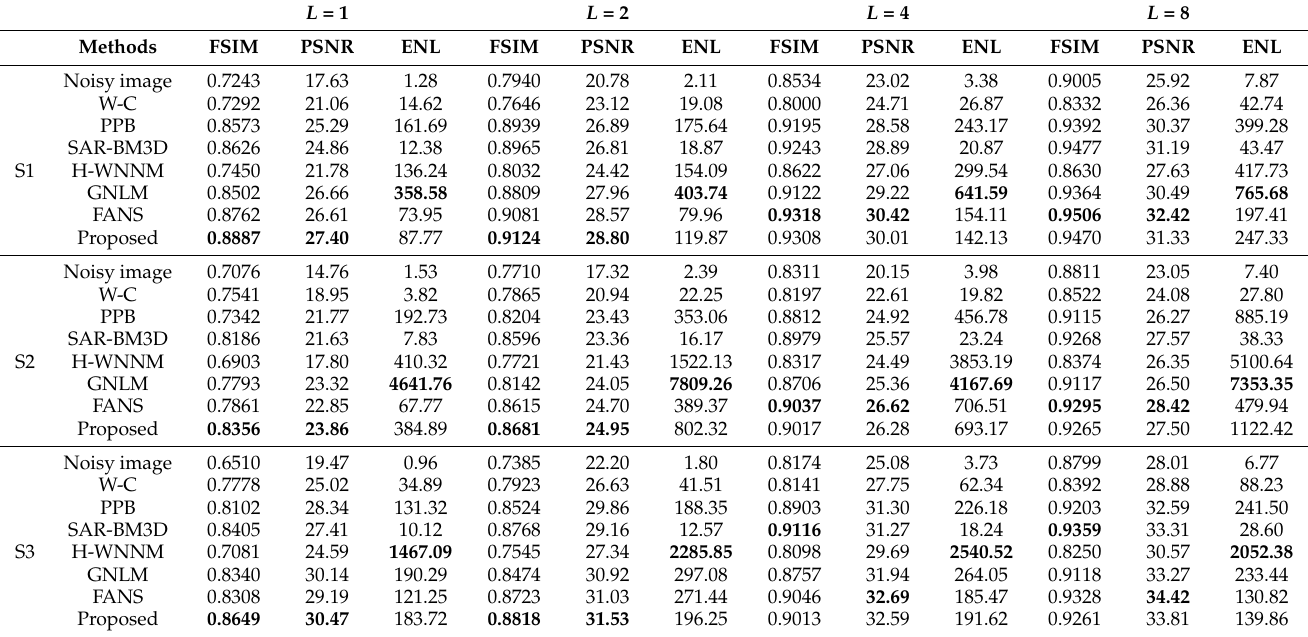
Table 3. The FSIM, PSNR, and ENL of all filters on the synthesized multiplicative noise images ( L = 1, 2, 4, 8).